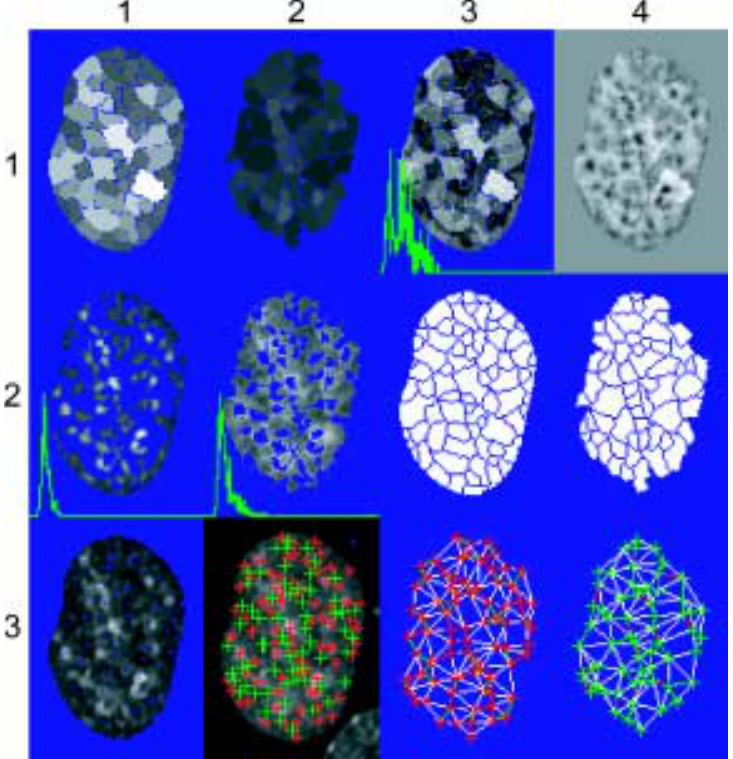
Fig. 13. Feature display during calculation (rice field). References are given by (column line) coordinates. (1 1) upper rice field [94], (2 1) lower rice field, (3 1) difference of upper and lower rice field ( RG ... ), (4 1) second difference D 2 , (1 2) upper half height partition ( HU ... ), (2 2) lower half height partition ( HL ... ), (3 2) upper watershed regions, (4 2) lower watershed regions, (1 3, 2 3) locations of the particle extrema, (3 3, 4 3) neighborhood graphs on bright and dark particles for structure analysis (Delaunay triangulation and minimum spanning tree graph)